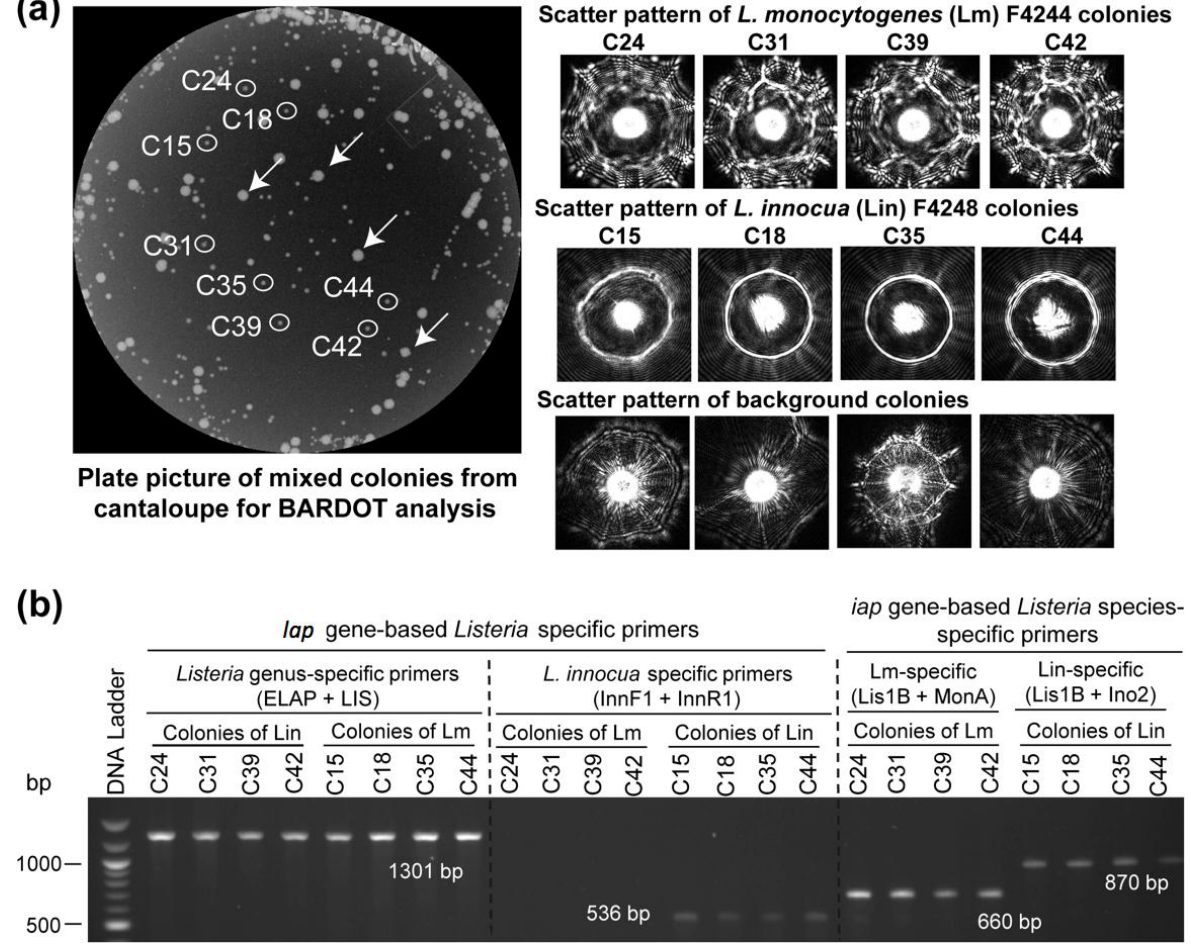
Figure 6. Detection and verification of L. monocytogenes (Lm) and L. innocua (Lin) in mixture from inoculated cantaloupe samples with BARDOT and PCR. ( A ) Enriched cantaloupe samples containing L. monocytogenes and L. innocua were plated on BHI agar and colony scatter patterns were obtained. Scatter patterns were matched against the BARDOT scatter image library for Listeria identification. The white arrows indicate background bacterial colonies from the cantaloupe; ( B ) BARDOT identified colonies were picked and tested with the primer sets specific for species of Listeria sensu stricto (ELAP-F1/LIS-R1), L. monocytogenes (Lis1B/MonA), and L. inn ocua (InnF1/InnR1, Lis1B/Ino2) for verification of